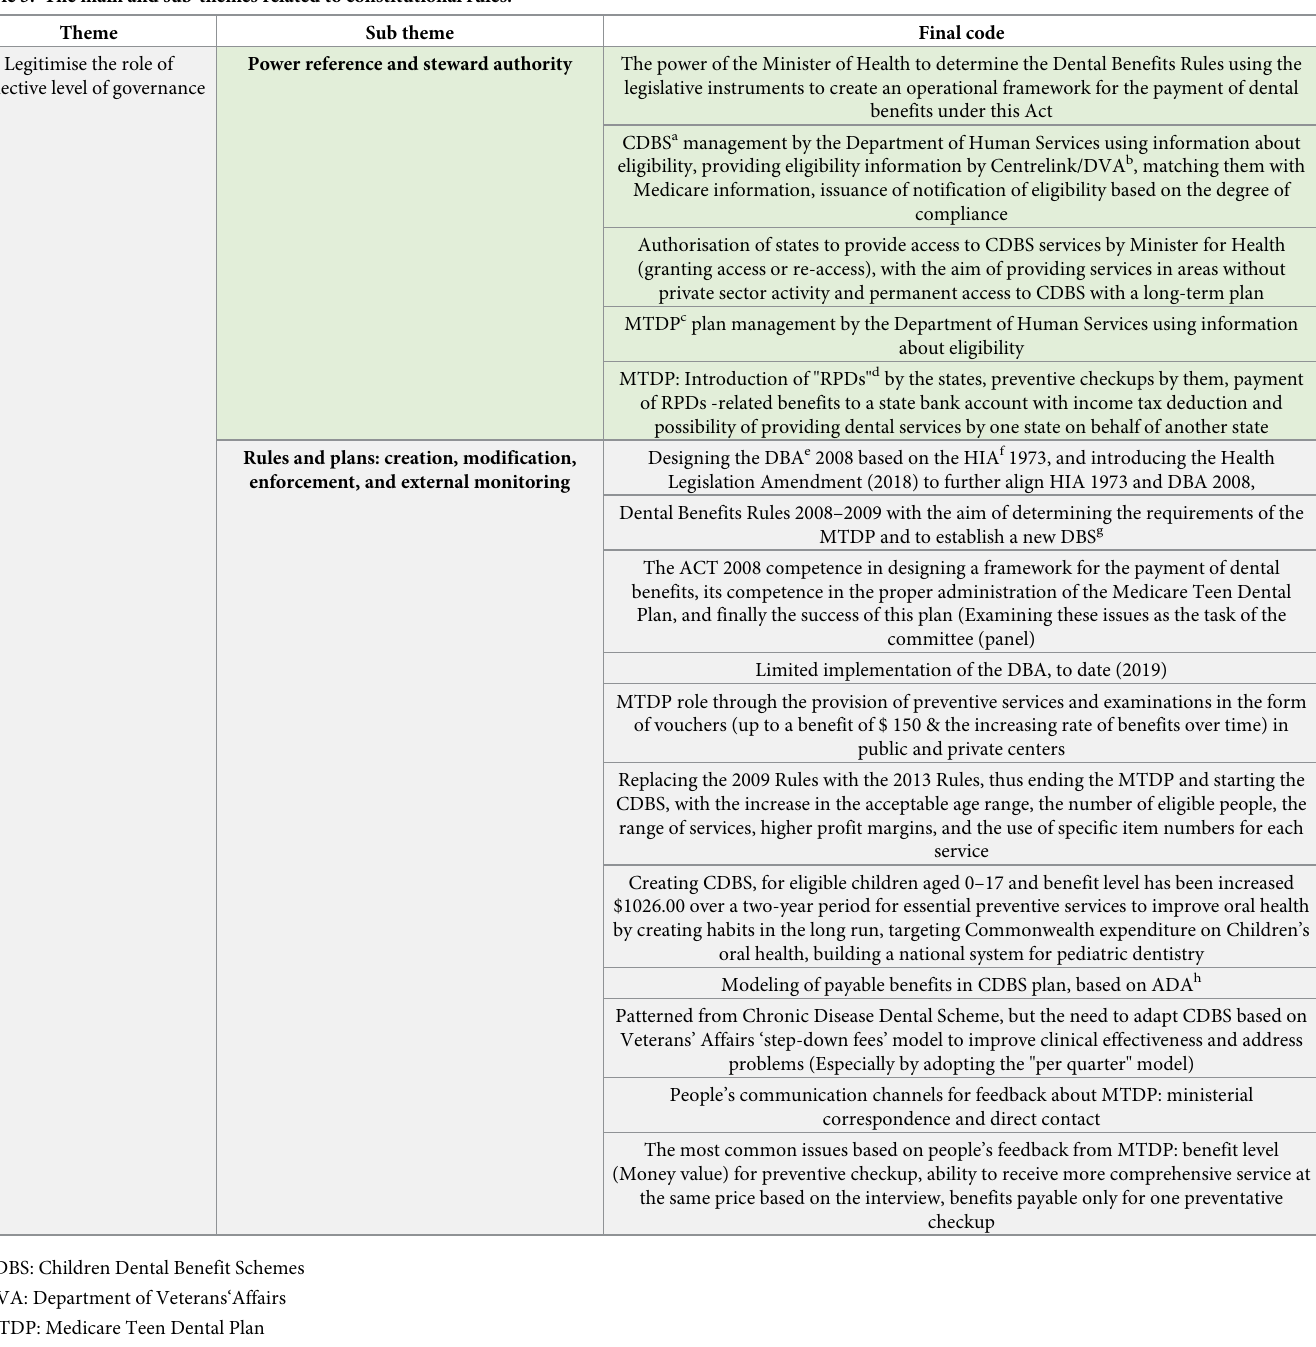
Table 3. The main and sub-themes related to constitutional